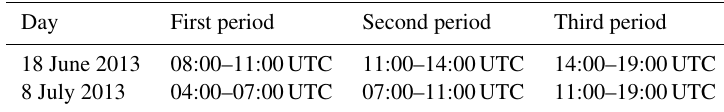
Table 2. Periods on both selected days, which are used for the comparisons.